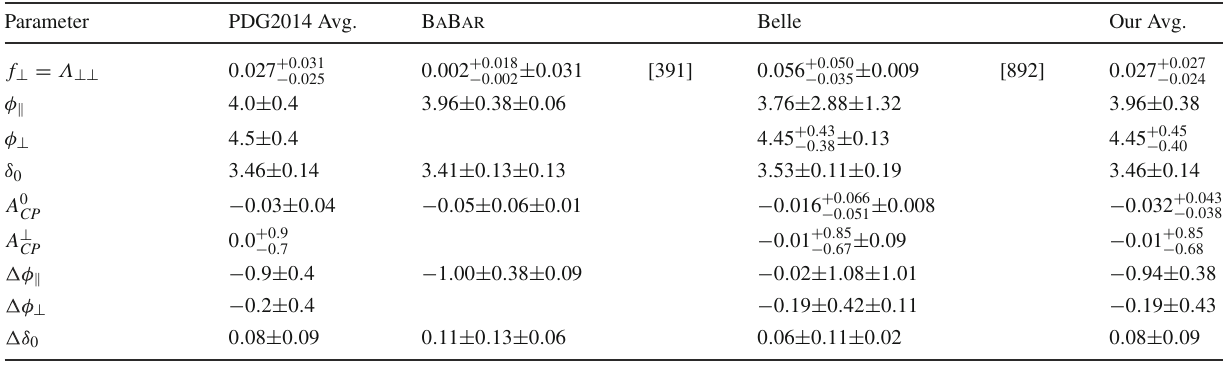
( 1430 ) decays. Where values are shown in red (blue), this indicates that they 2